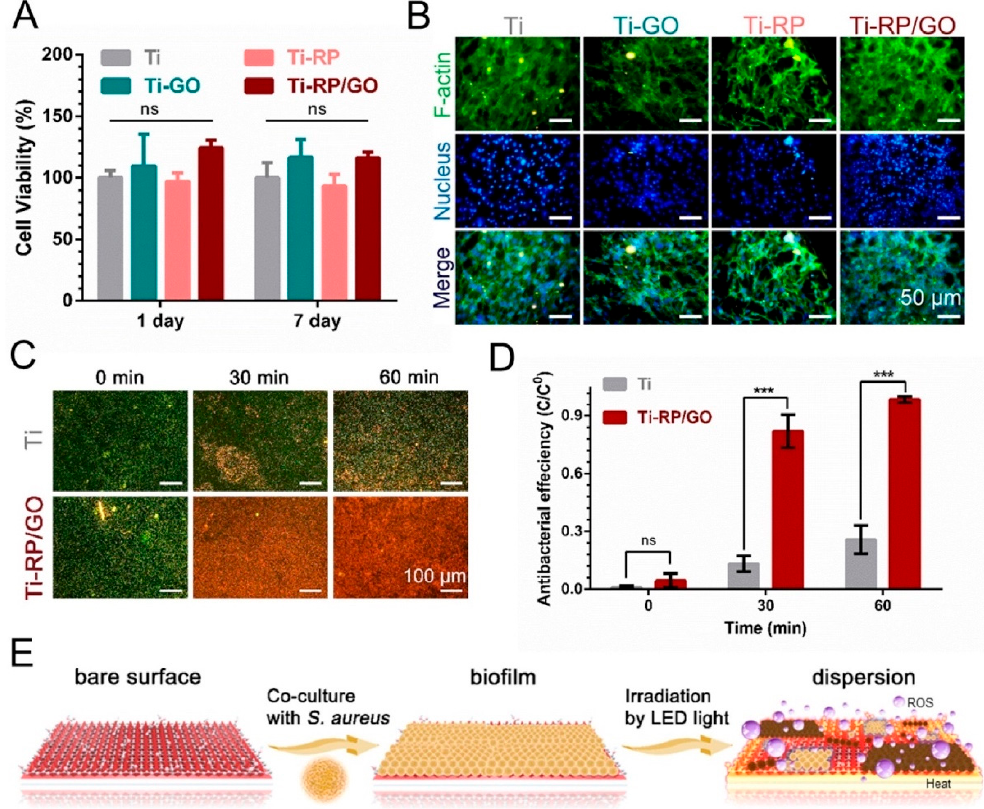
Figure 7. Cellular response to ( A ) the cytotoxicity of NH3T3 cells after co-culturing for 1 and 7 days and ( B ) fluorescence staining on the surfaces of samples after co-culturing with NH3T3 cells for 24 h. ( C ) The fluorescent assay of Staphylococcus aureus biofilm after irradiation with LED light (at 0.1 W / cm 2 ). Green represents living bacteria, while red represents dead bacteria. ( D ) Quantitative analysis of the fluorescent assay by Image J software. ( E ) Schematic diagram of biofilm dispersion. Reproduced from [60], with permission from Elsevier, 2020.